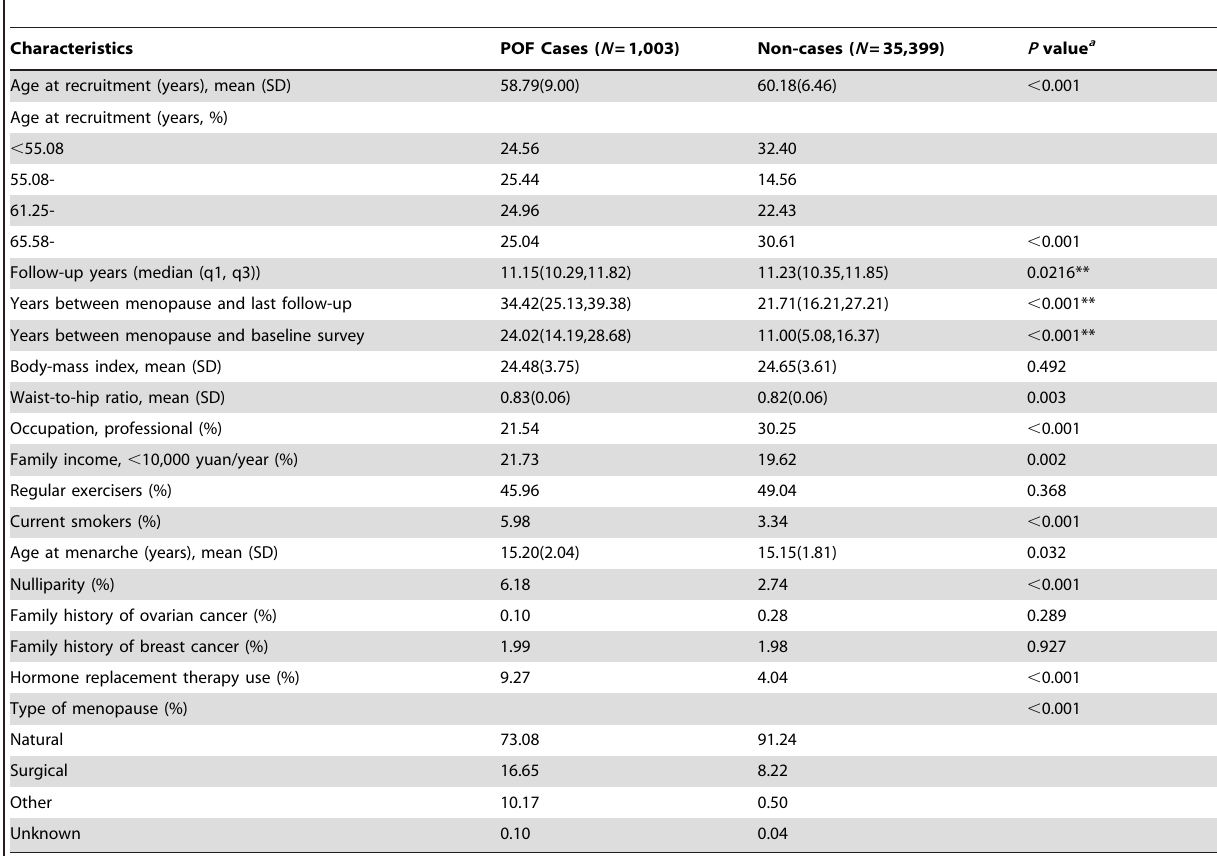
Table 1. Comparison of selected characteristics at baseline between POF cases and non-cases in the Shanghai Women’s Health